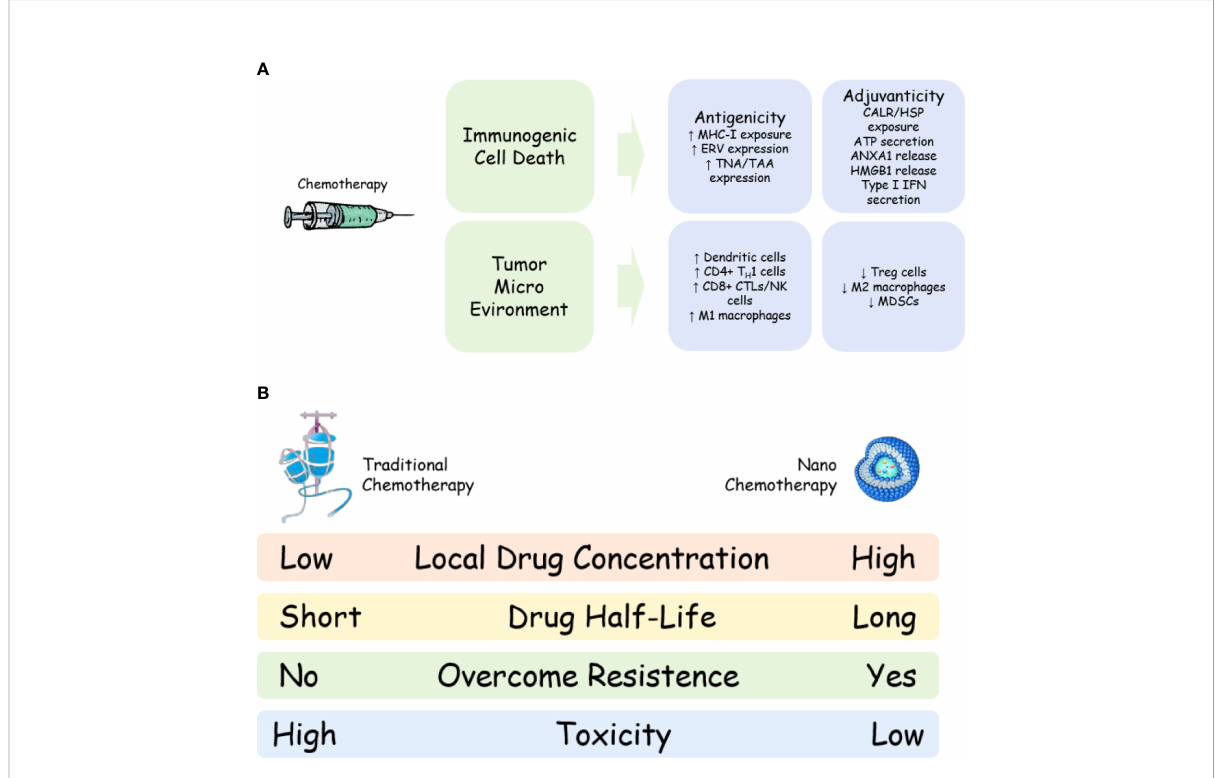
FIGURE 1 Mechanism and advantage of nano-chemotherapy. (A) Mechanism of chemotherapy to synergize with immune checkpoint inhibitor; (B) Advantages of nano-chemotherapy compared with traditional chemotherapy. MHC-I, major histocompatibility complex class I;ERV, endogenous retrovirus; TAA, tumour associated antigen; TNA, tumour neoantigen; CALR, calreticulin; HSP, heat shock protein;ANXA1, annexin A1; HMGB1, high mobility group box 1; IFN, interferon; TH1, T helper 1; CTL, cytotoxic T lymphocyte; NK, natural killer cells; MDSC, myeloid- derived suppressor cell; Treg, regulatory T